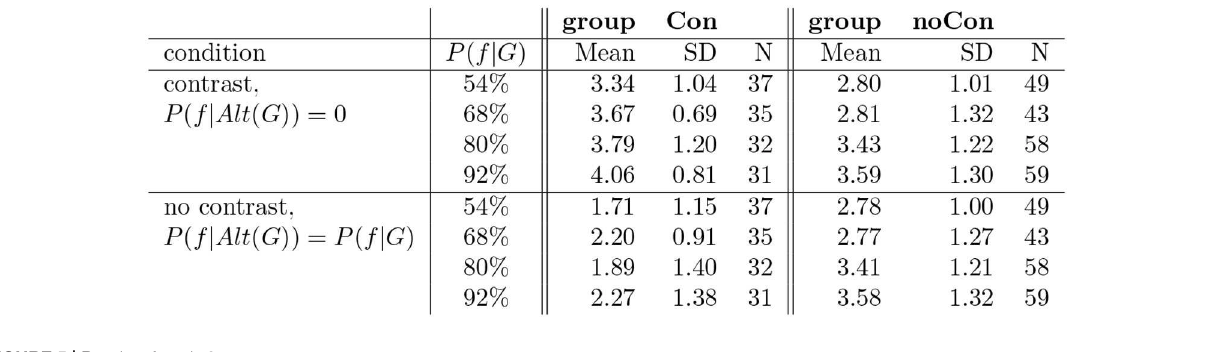
FIGURE 5 | Results of study